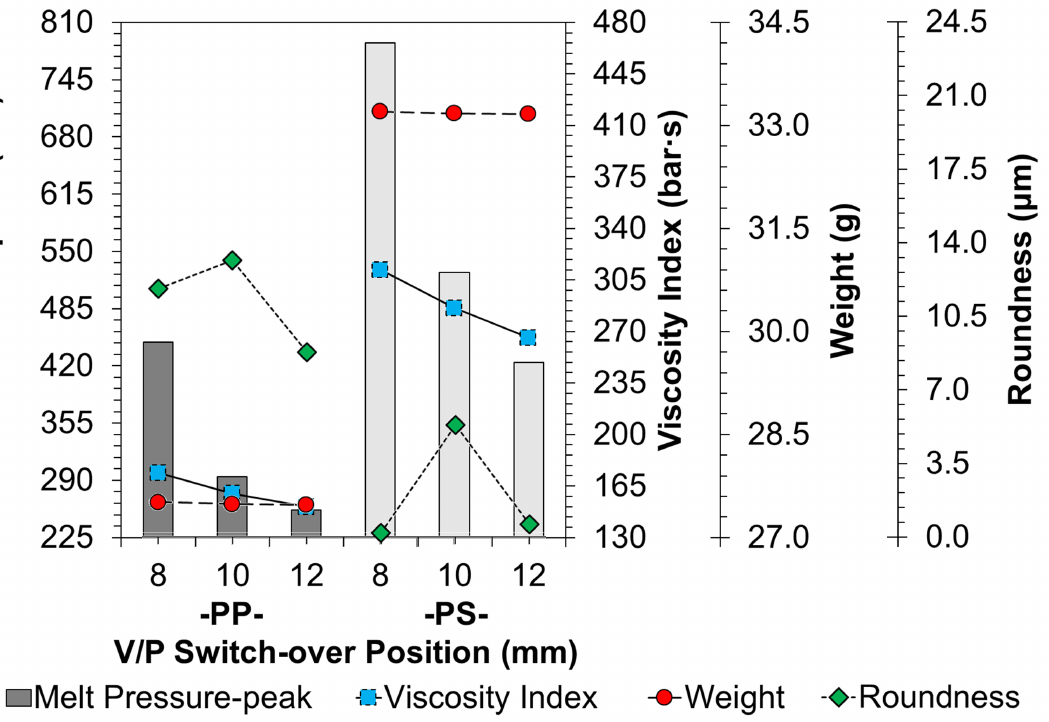
Figure 15. Trend-diagram of the effect of V/P switch-over position on melt pressure-peak (bar- graph), calculated viscosity index (continuous-line), and its sample weight (chain-line)/roundness (dotted-line).